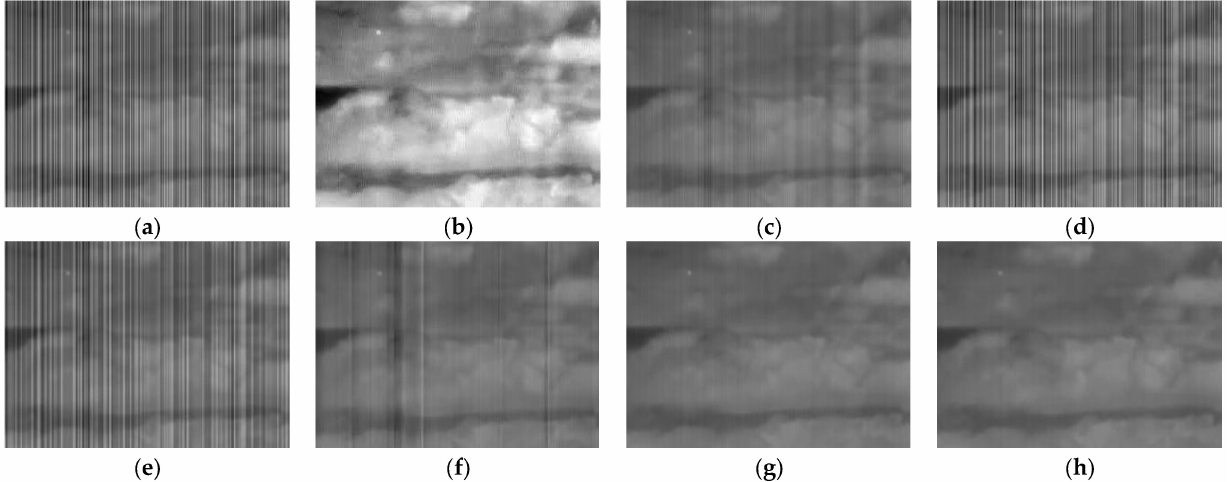
Figure 10. Comparison of methods using high-intensity nonuniformity infrared dim small target images: ( a ) infrared dim small target image with high-intensity nonuniform noise added; ( b ) MHE; ( c ) 1D-GF; ( d ) SNRCNN; ( e ) ICSRN; ( f ) DLS-NUC; ( g ) SNRWDNN; ( h ) ours.